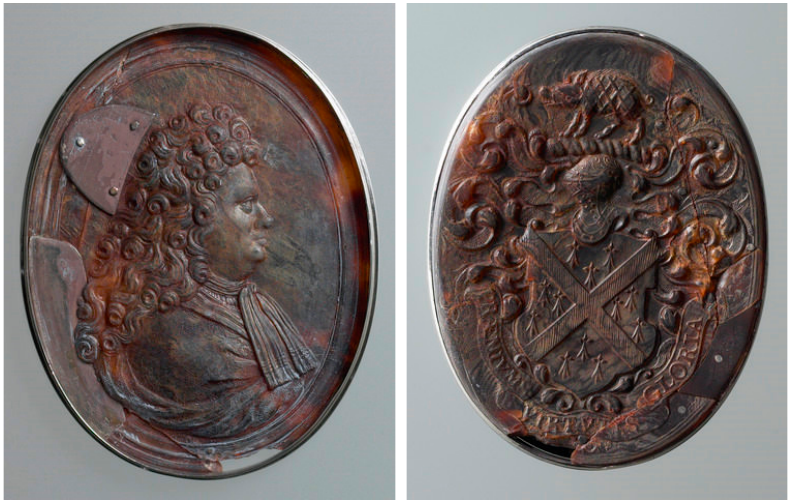
Figure 4. John Obrisset, snuffbox, c. 1705–28, 1.4 × 8.3 × 6.5 cm (1788.1). Yale University Art Gallery; Gift of Ezra Stiles. Public domain.